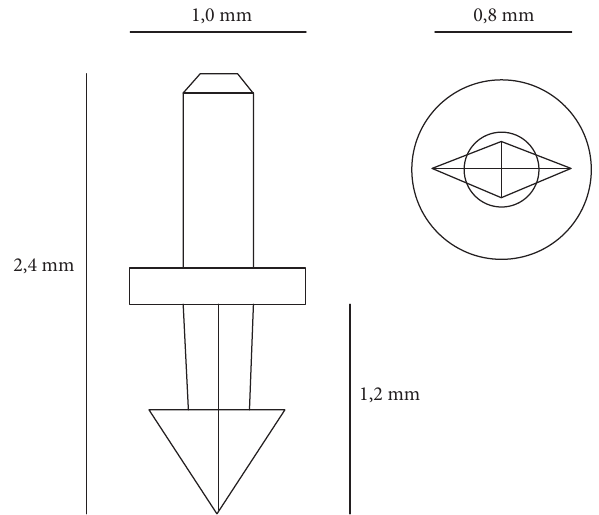
Figure 1: Schematic representation of the retinal tack. On the right side: lateral view of the tack. On the left side: inferior view of the